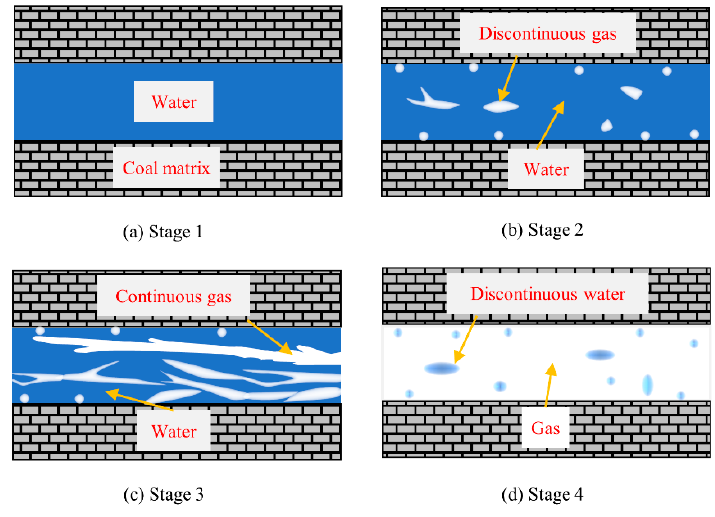
Figure 1. Four stages in the production of coalbed methane (CBM).